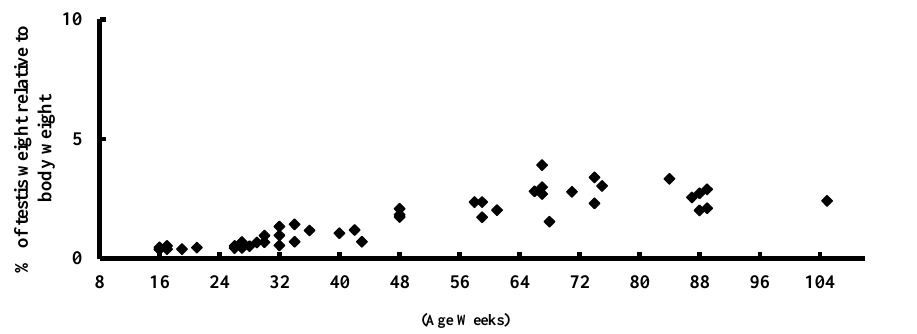
Figure 9. Relative percentage of the bi-testis weight to the body weight in the sacrificed animals ( n = 48).